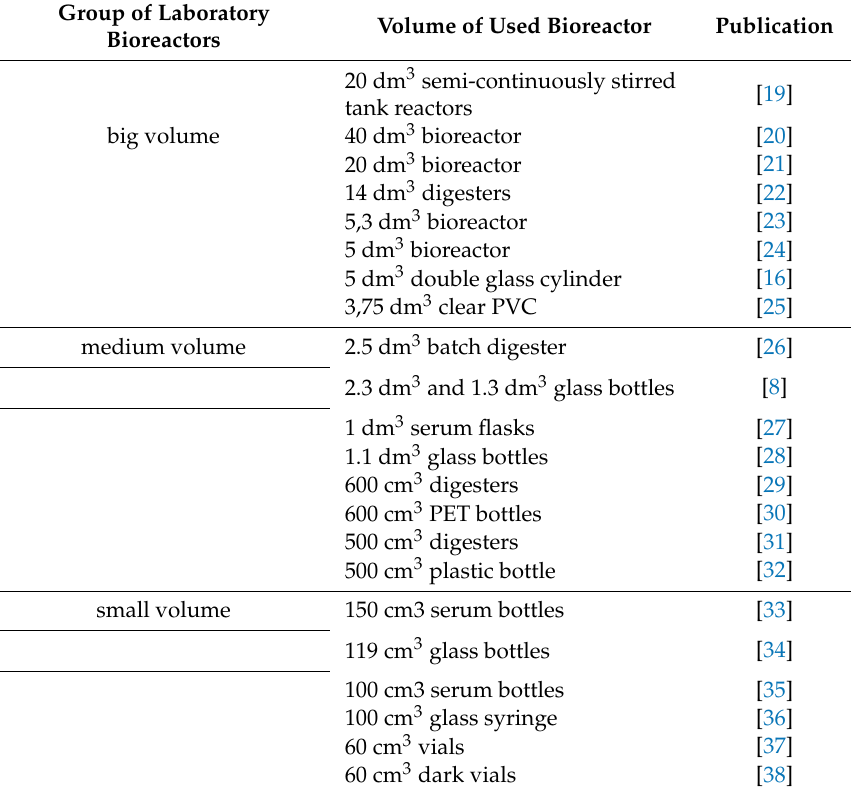
Table 1. Review of laboratory investigations and the bioreactors used in these